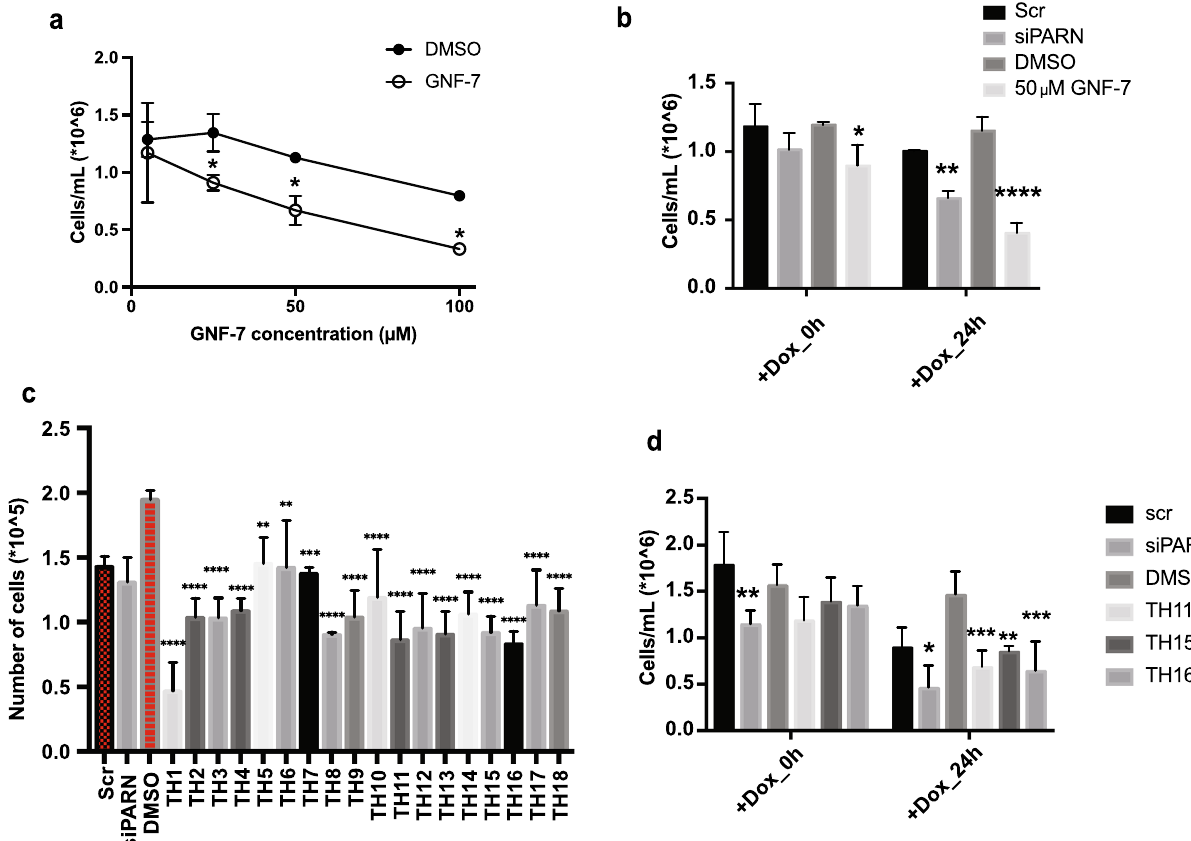
Figure 8. Cell death assay for GNF-7 treatment. ( a ) Numbers of cells at 2 days after DMSO and GNF-7 treatment. 2-way ANOVA, multiple comparisons test, average ± SD, N = 3 biological replicates, n = 1. ( b ) Numbers of cells at 0 and 24 h-post doxorubicin treatment. Hela cells were treated with siPARN or GNF-7 for 2 days (scramble siRNA and DMSO as controls) before adding doxorubicin. Cells were collected for quantification after 0- and 24-h post doxorubicin treatment. 2-way ANOVA, multiple comparisons test, average ± SD, N = 3 biological replicates, n = 1. *P < 0.05, **P < 0.005, ***P < 0.001, ****P < 0.0001, n.s. was not indicated. ( c ) Numbers of cells at 2 days after DMSO and TH1-TH18 treatment. One-way ANOVA, multiple comparisons test, average ± SD, N = 3 biological replicates, n = 1 ( d ) Numbers of cells at 0 and 24